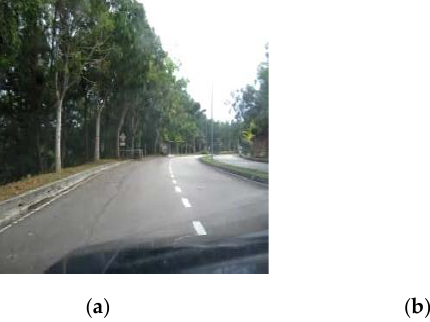
Figure 16. Autonomous detection and navigation of the proposed system in the road following with 5 m as width and 500 m as length: ( a ) original image, ( b ) image processing, and ( c ) generation of the path within the road following environment.